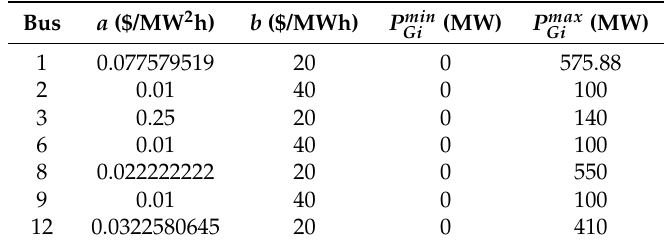
Table 2. Generator parameters in IEEE 57-bus